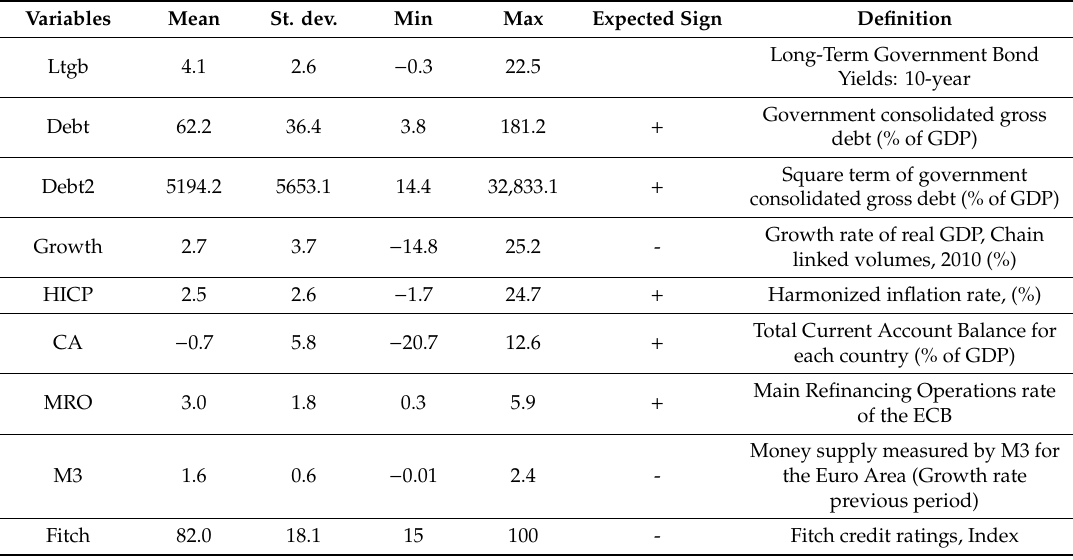
Table 1. Descriptive statistics, expected signs and definitions of the variables